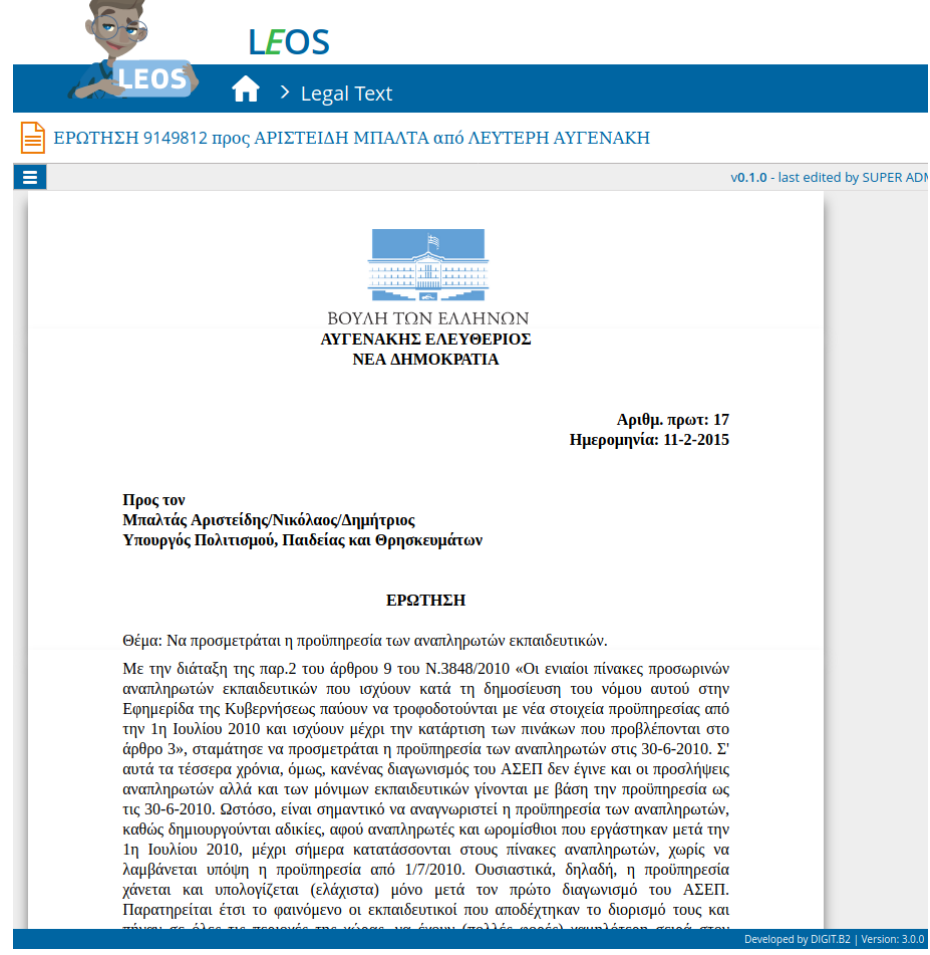
Figure 3. Web UI rendition based on the uploaded document.